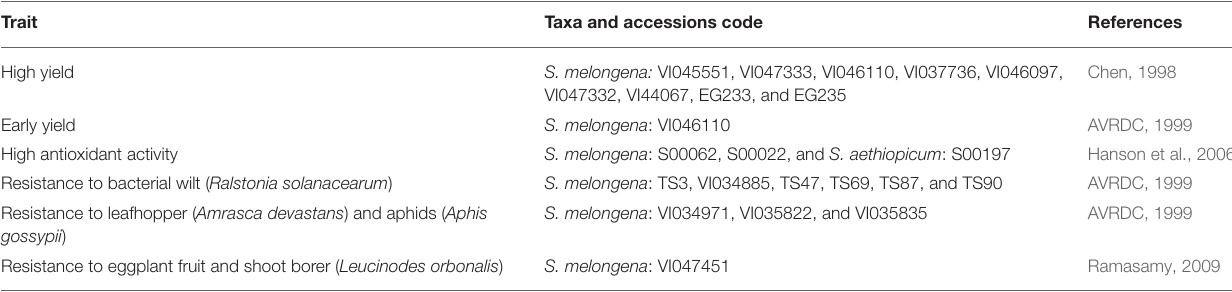
TABLE 6 | Identified eggplant germplasm from the World Vegetable Center collection with useful traits for breeding. Trait Taxa and accessions